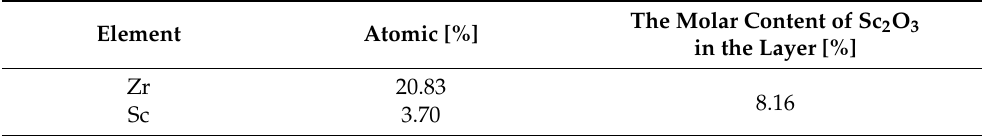
Table 5. Average chemical composition determined by EDS analysis and calculated molar content